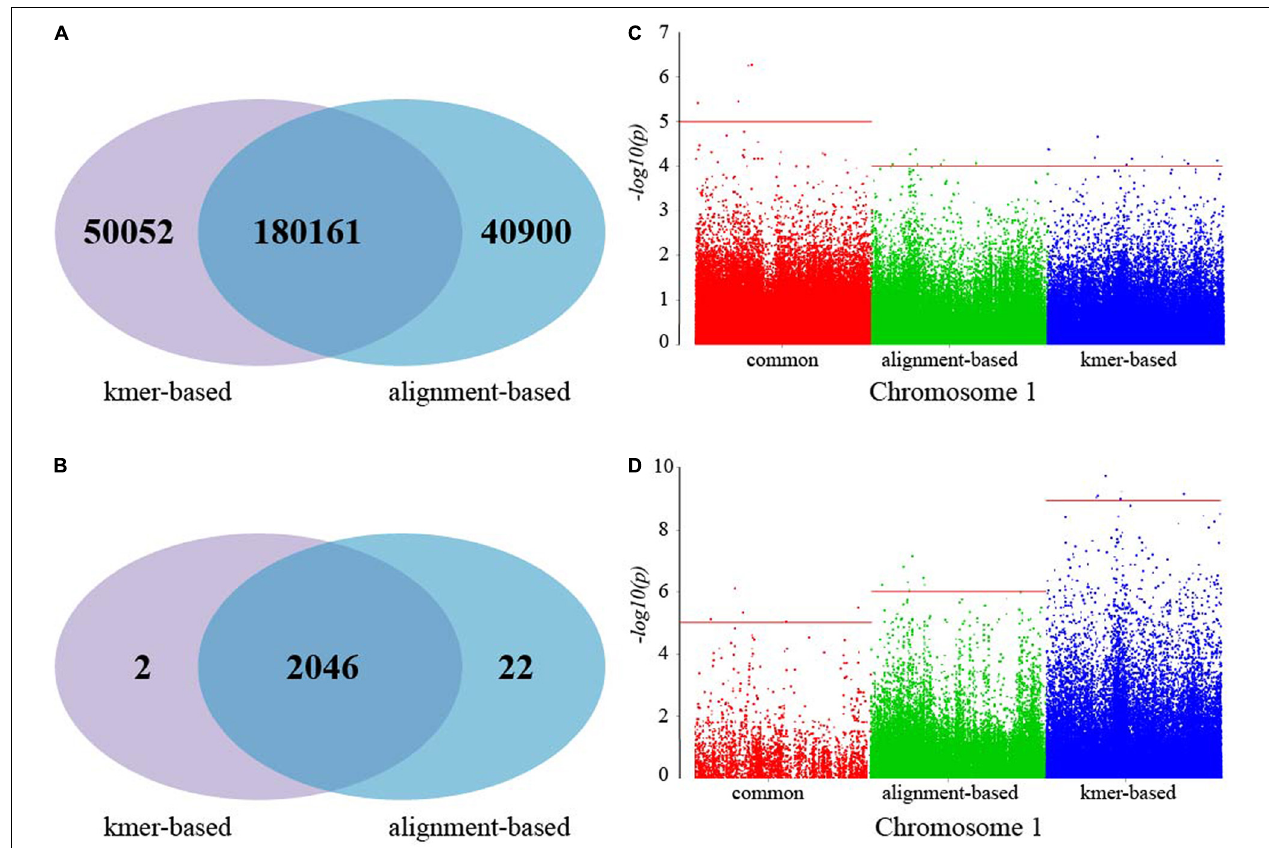
FIGURE 3 | The comparison of the results from the alignment-based and the k -mer-based strategies. (A) The Venn diagram of candidate variants from k -mer-based and alignment-based strategies; (B) the Venn diagram of genes including variants from k -mer-based and alignment-based strategies; (C) the Manhattan plots for MWR traits from common, alignment-based, and k -mer-based SNPs; (D) the Manhattan plots for SLW traits from common, alignment-based, and k -mer-based